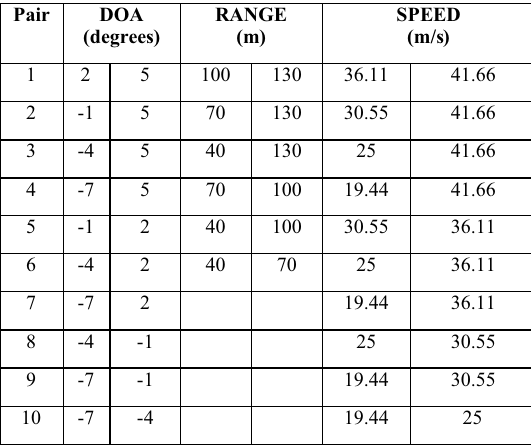
TABLE III. P AIRS OF RANGES , ANGLES , AND SPEEDS CAR